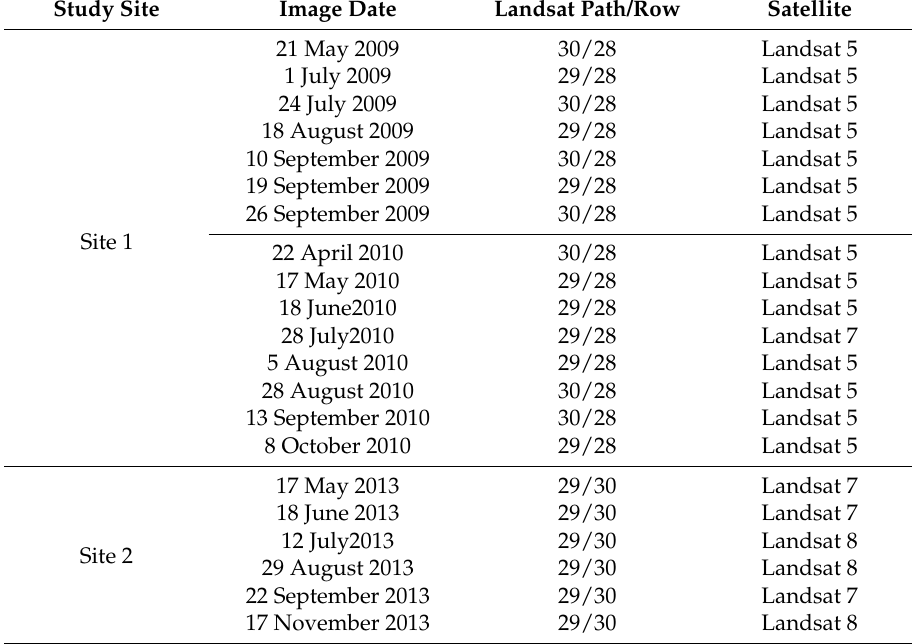
Table 2. Selected Landsat image dates with Landsat path/row and satellite